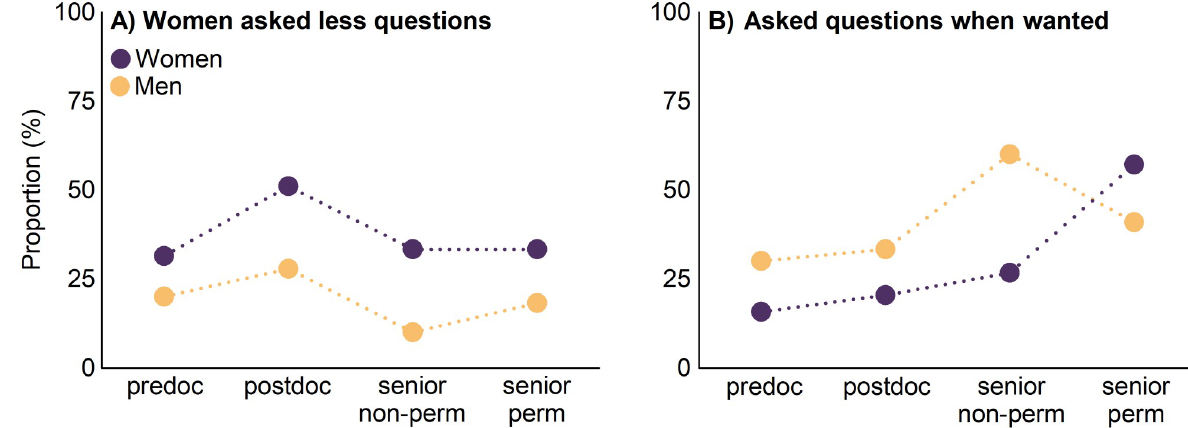
Fig 5. Proportion of participants that answered in the post-conference survey (A) “women asked less questions than men during oral communications” and (B) “I always asked questions when I wanted to”. The proportion is shown for each gender separately (e.g., women that responded to a specific answer/total number of women that participated in the survey). Abbreviations: master students and predoctoral researchers (predoc), postdoctoral researchers (postdoc), senior researchers with non-permanent positions (senior non-perm), senior researchers with permanent positions (senior